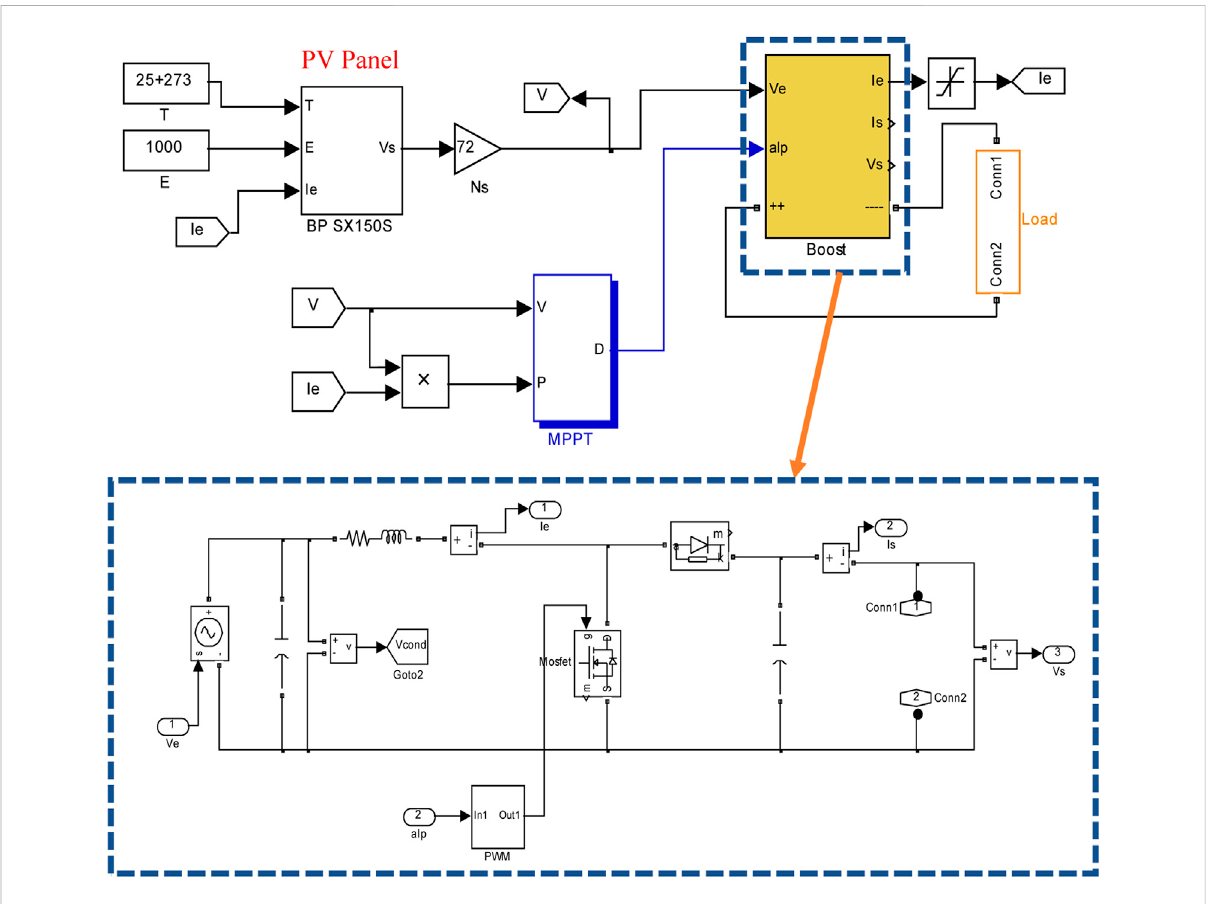
FIGURE 7 The PV system under